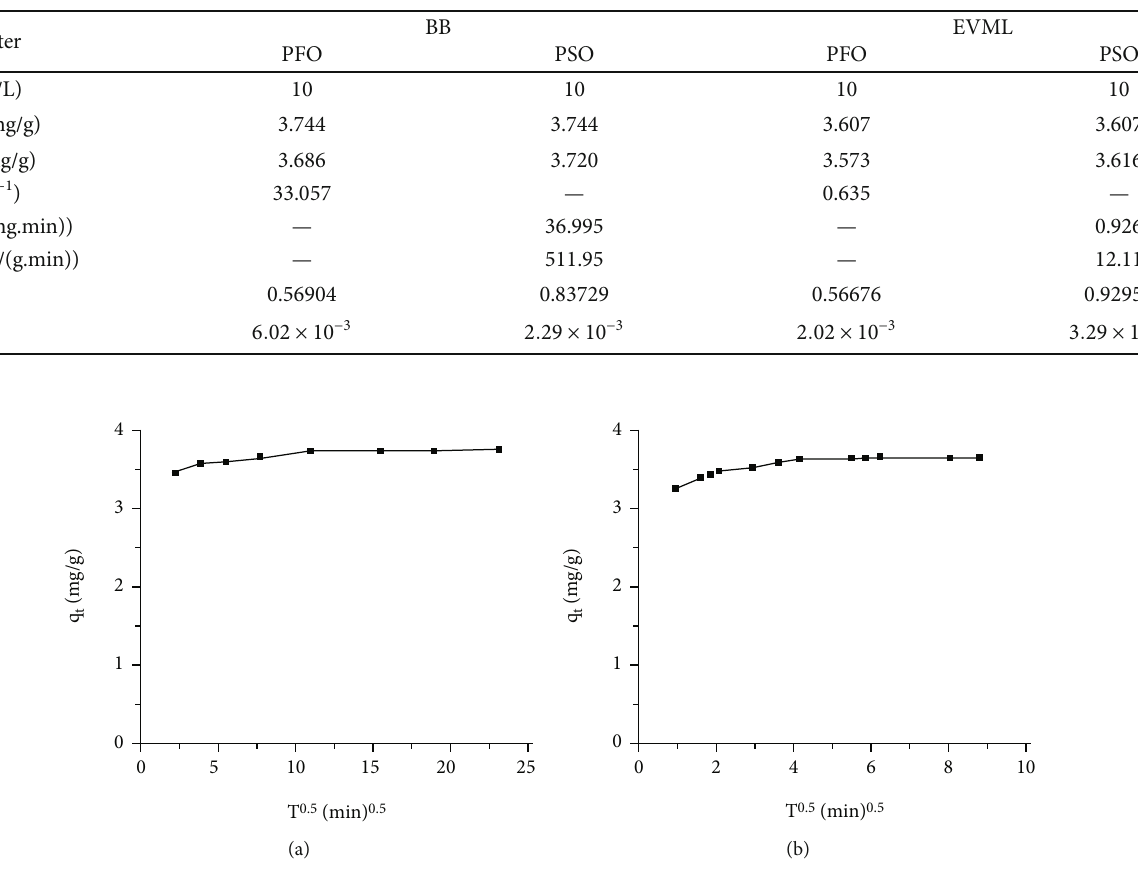
Figure 6: Intraparticle di ff usion model plot for the (a) BB and (b)